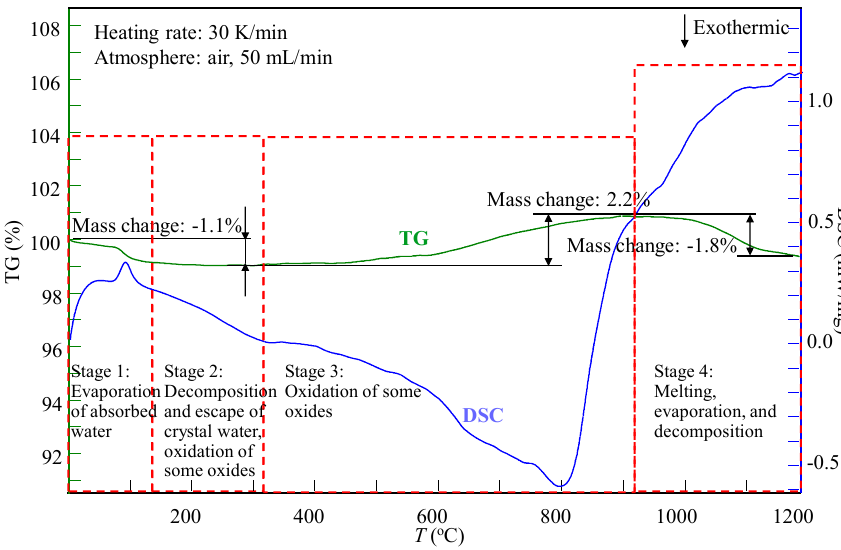
Figure 4. TG-DSC analysis of vanadium-bearing titanomagnetite concentrate.